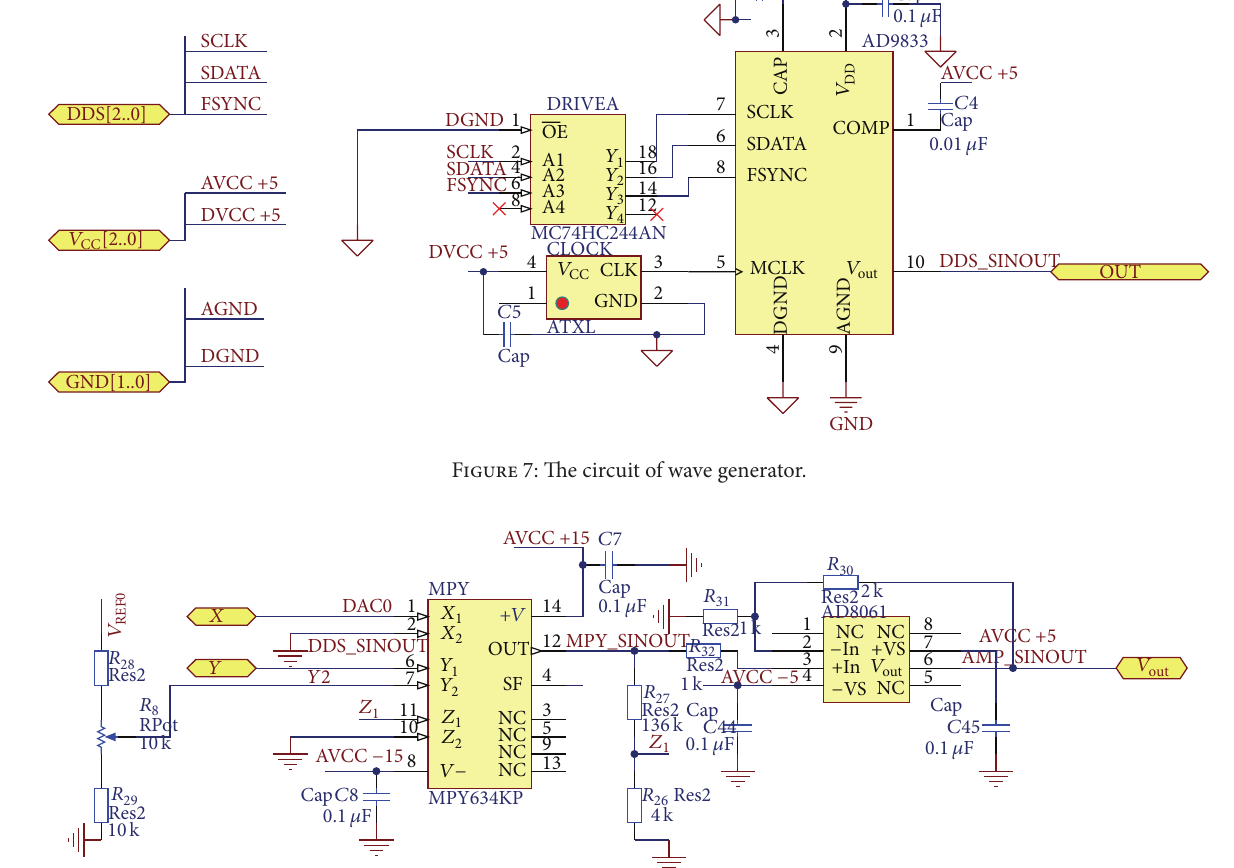
Figure 8: The circuit of regulating the sinusoidal